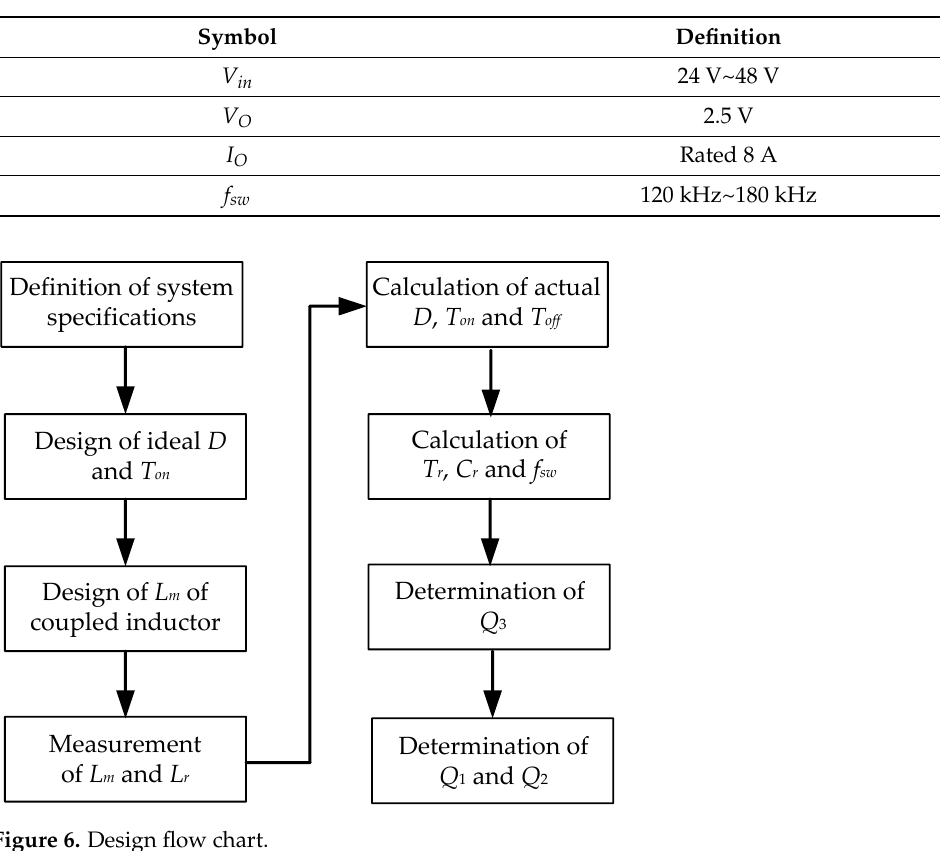
Figure 5. Circuit structure of the prototype circuit. Table 1. Specification of the prototype circuit.